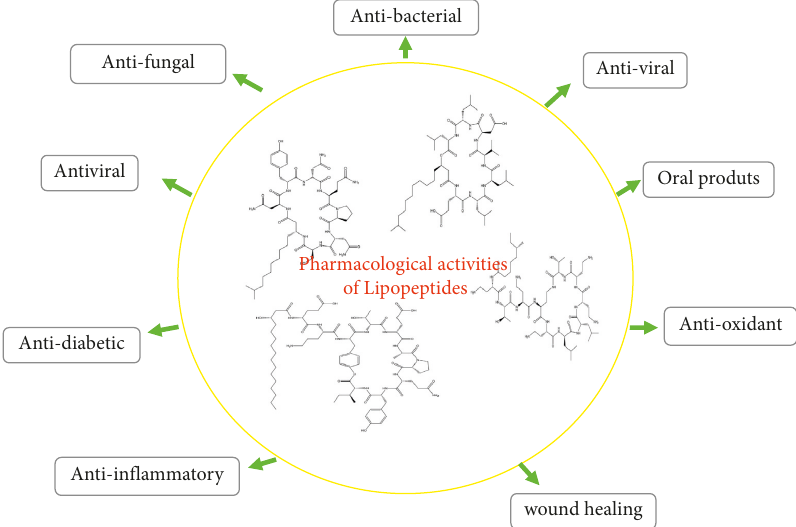
Figure 2: Pharmacological activities of